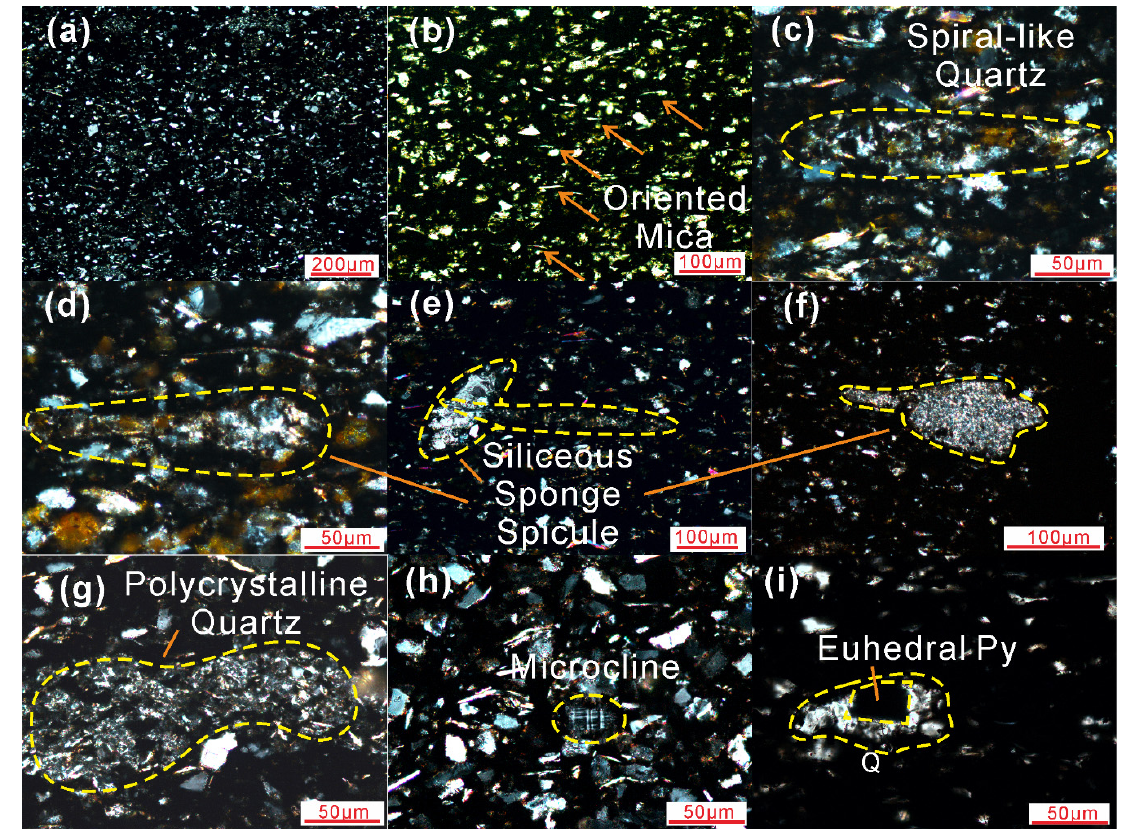
Figure 6. Thin section photographs of shale samples (with the exception of ( b , i ), all photos with crossed polarizers). ( a ) Sample N-5 containing high amounts of detrital quartz and feldspar. Lam- ination is not developed; ( b ) N-3 showing oriented mica; ( c ) spiral-like quartz, N-3; ( d – f ) siliceous sponge spicules, all from N-3; ( g ) polycrystalline quartz, N-6 ( h ) microcline, N-4; ( i ) replacement of large scale quartz by pyrite, N-2. Q: quartz.